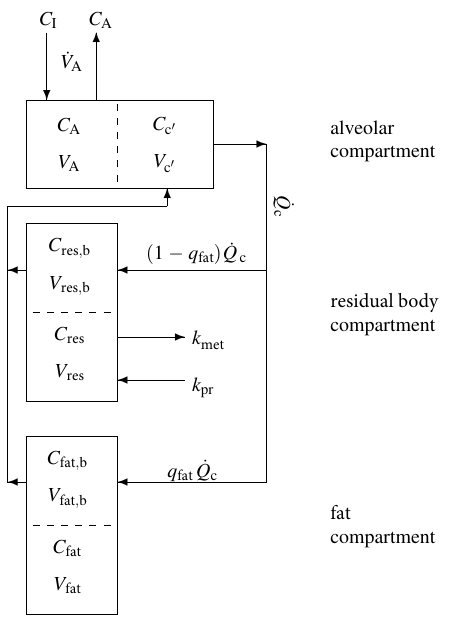
Figure 1. Sketch of the model structure. The body is divided into three distinct functional units: alveolar/end-capillary compartment (gas exchange), residual body compartment (metabolism and production), and fat compartment (storage). Dashed boundaries indicate a diffusion